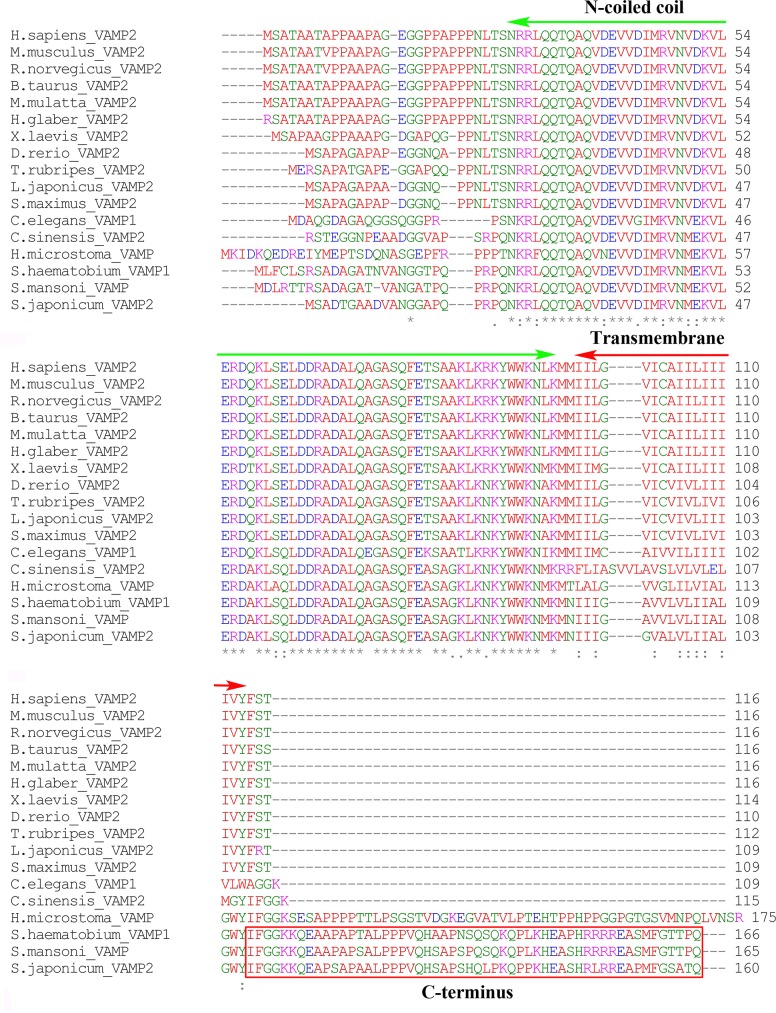
Multiple alignment of SjVAMP2 with the VAMP2 of other animals.The color of letters denotes physicochemical properties of amino acids: red—small and hydrophobic; green—hydroxyl, sulfhydryl, amine and G; magenta—basic; and blue—acidic. The conserved domain of amino acid residues is displayed with different consensus symbols: An asterisk (*) indicates positions that have a single, fully conserved residue; a colon (:) indicates conservation between groups of strongly similar properties–scoring > 0.5 in the Gonnet PAM 250 matrix; a period (.) indicates conservation between groups of weekly similar properties–scoring ≤ 0.5 in the Gonnet PAM 250 matrix. N-coiled coil homology and transmembrane domains are showed in regions of bars with green or red colors respectively. Red boxed residues are C-terminus conserved domain in VAMP of schistosome. Aligned sequences are Homo sapiens (NP_ 055047.2), Mus musculus (NP_ 033523.1), Rattus norvegicus (NP_036795.1), Bos taurus (NP_776908.1), Macaca mulatta (EHH24500.1), Heterocephalus glaber (EHB04514.1), Xenopus laevis (NP_001080944.1), Danio rerio (NP_956299.1), Takifugu rubripes (NP_003976339.1), Lateolabrax japonicus (AAT67161.2), Scophthalmus maximus (CCD74823.1), Caenorhabditis elegans (NP_504688.1), Clonorchis sinensis (GAA52723.1), Hymenolepis microstoma (CDS31115.1), Schistosoma haematobium (KGB32859.1), Schistosoma mansoni (CCD74823.1), and Schistosoma japonicum (AAP05935.1).